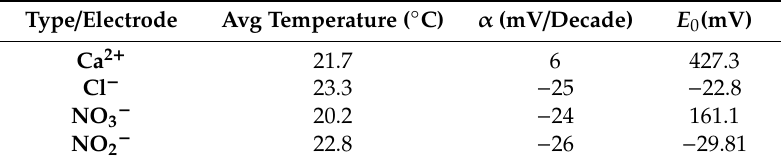
Table 3. Experimentally Determined Nernst Parameters for selective ions.